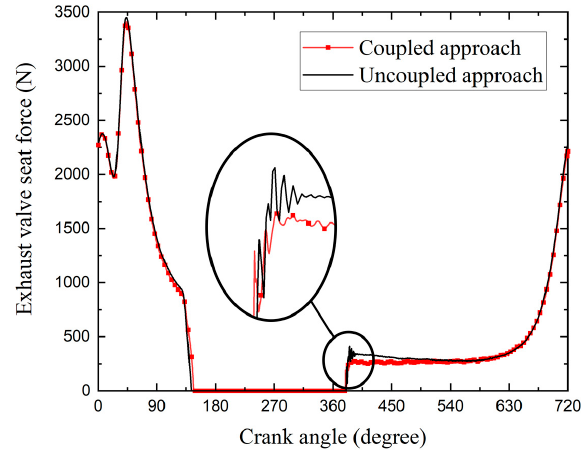
Figure 22. The exhaust valve seating force comparison between the two approaches.